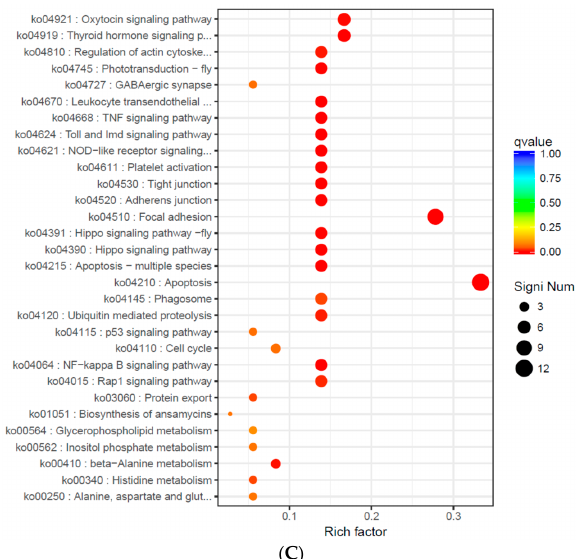
Figure 4. Scatterplot of KEGG pathways enriched in the DEGs for each pairwise comparison [( A ) S14 vs S22; ( B ) S14 vs S30; ( C ) S22 vs S30]. “Rich factor” represents the ratio of DEG numbers annotated with a pathway term relative to all genes annotated with this pathway term. A higher rich factor indicates greater intensity. The qvalue is the corrected p value (range, 0 to 1), and a lower q value denotes greater intensity. Only the top 30 enriched pathway terms are shown.